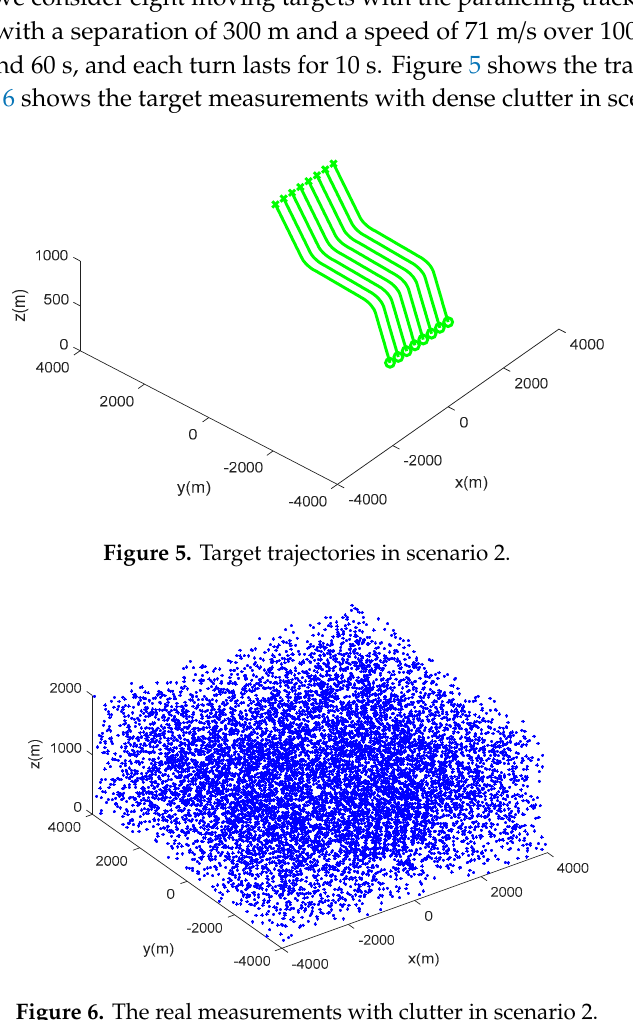
Figure 4. The real measurements with clutter in scenario 1.